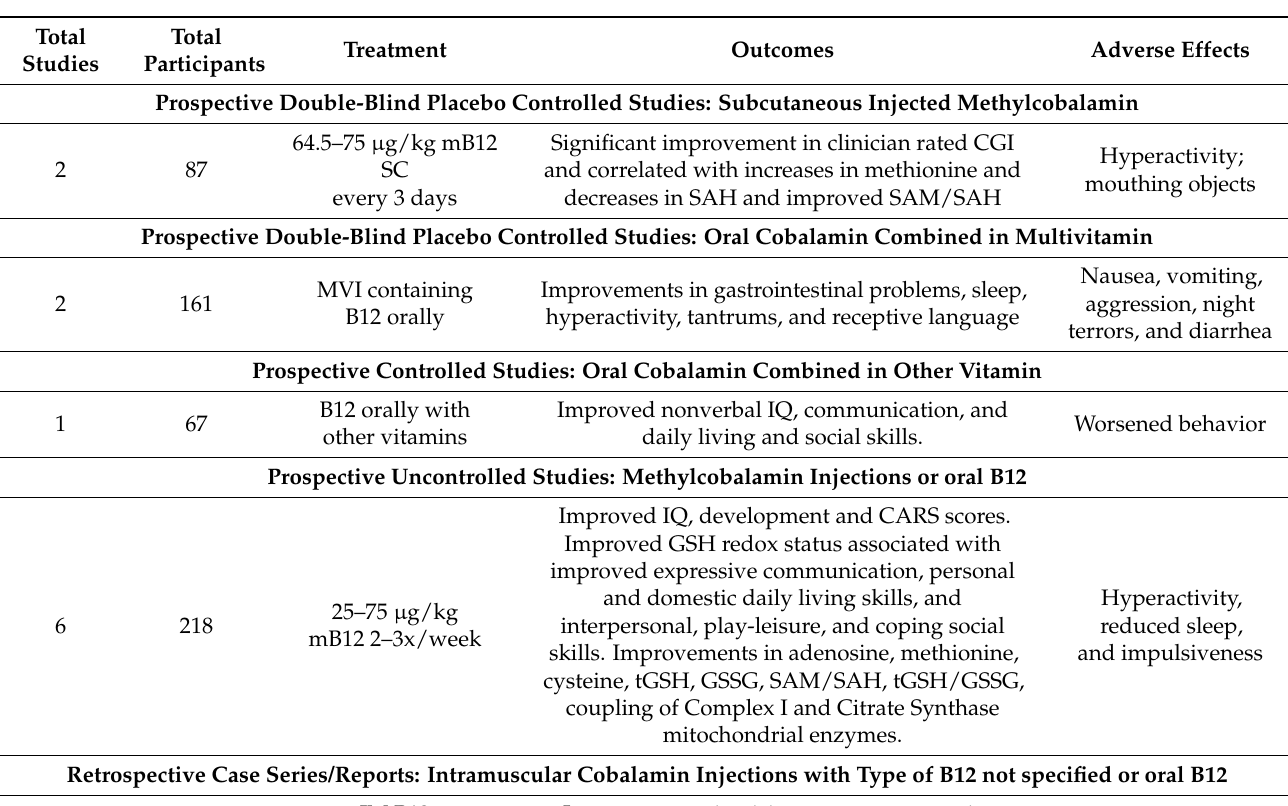
Table 6. Summary of studies on cobalamin treatment for ASD with clinical outcomes. Childhood Autism Rating Scale (CARS); Clinical Global Impression Scale (CGI); glutathione (GSH); oxidized glutathione (GSSG); intelligence quotient (IQ); multivitamin (MVI); S-adenosylhomocysteine (SAH); S-adenosylmethionine (SAM); methylation capacity (SAM/SAH); subcutaneous (SC); total GSH (tGSH); total glutathione redox ratio